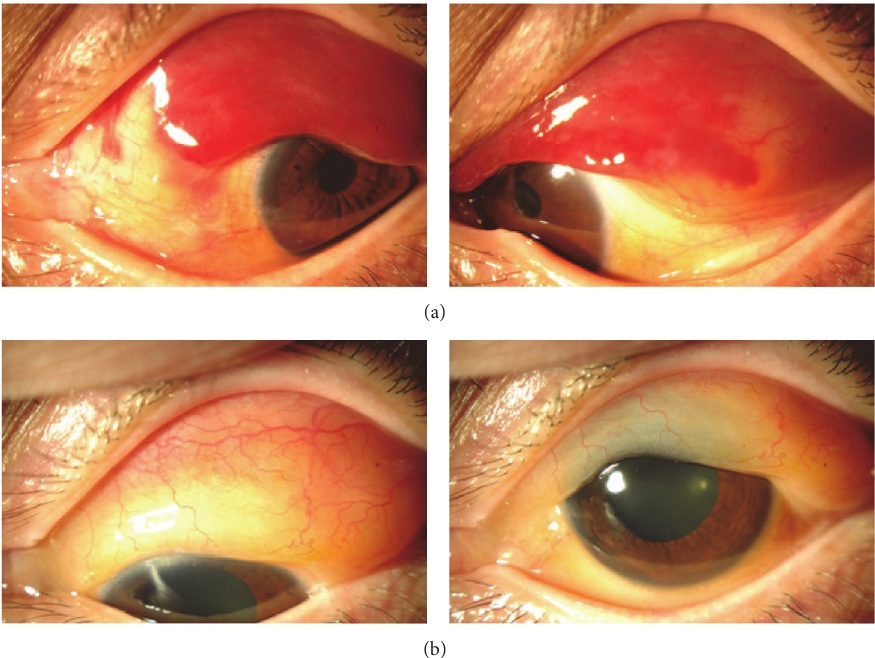
Figure 1: Slit-lamp photographs of anterior segment at the initial visit (a) and three months after the first visit (b). At the initial visit, subconjunctival hemorrhages masked amass.Threemonthslater, asalmon-pinkmasswas detected inthesuperiorarea